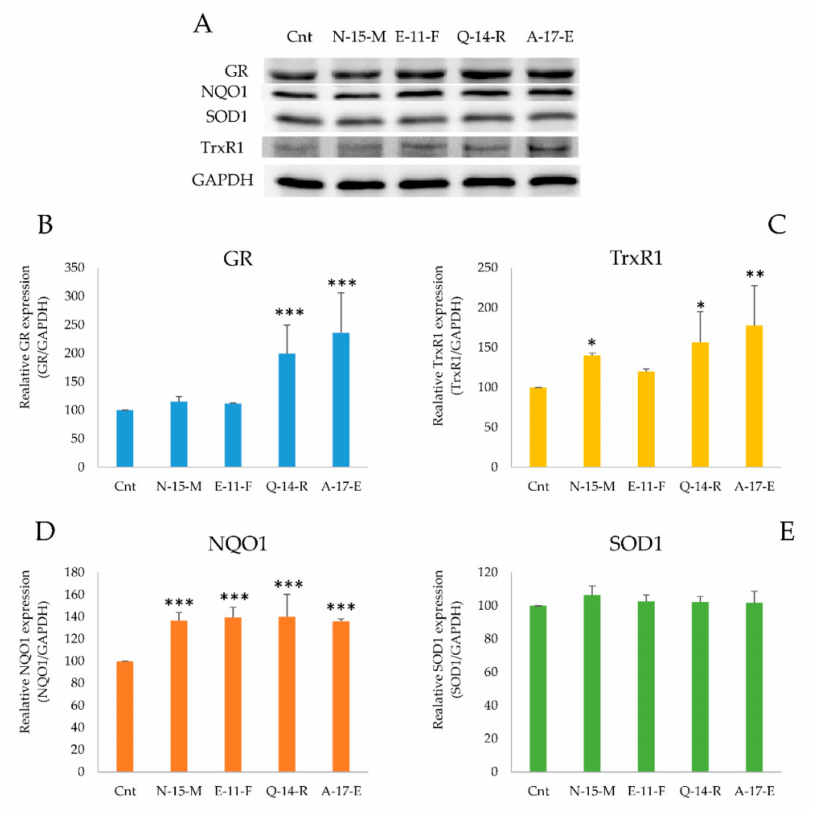
Figure 5. Antioxidant enzymes detection by WB analysis. ( A ) Protein levels of glutathione reductase (GR), thioredoxin reductase (TrxR1), NADPH quinone oxidoreductase (NQO1) and superoxide dismutase (SOD1) in Caco-2 cell lysates treated with the four peptides (0.05 mg / mL) for 24 h. ( B–E ) Densitometric analysis of four experiments were compared with the control and normalized using GAPDH as loading control. (*** p < 0.001, ** p < 0.01, * p < 0.05).